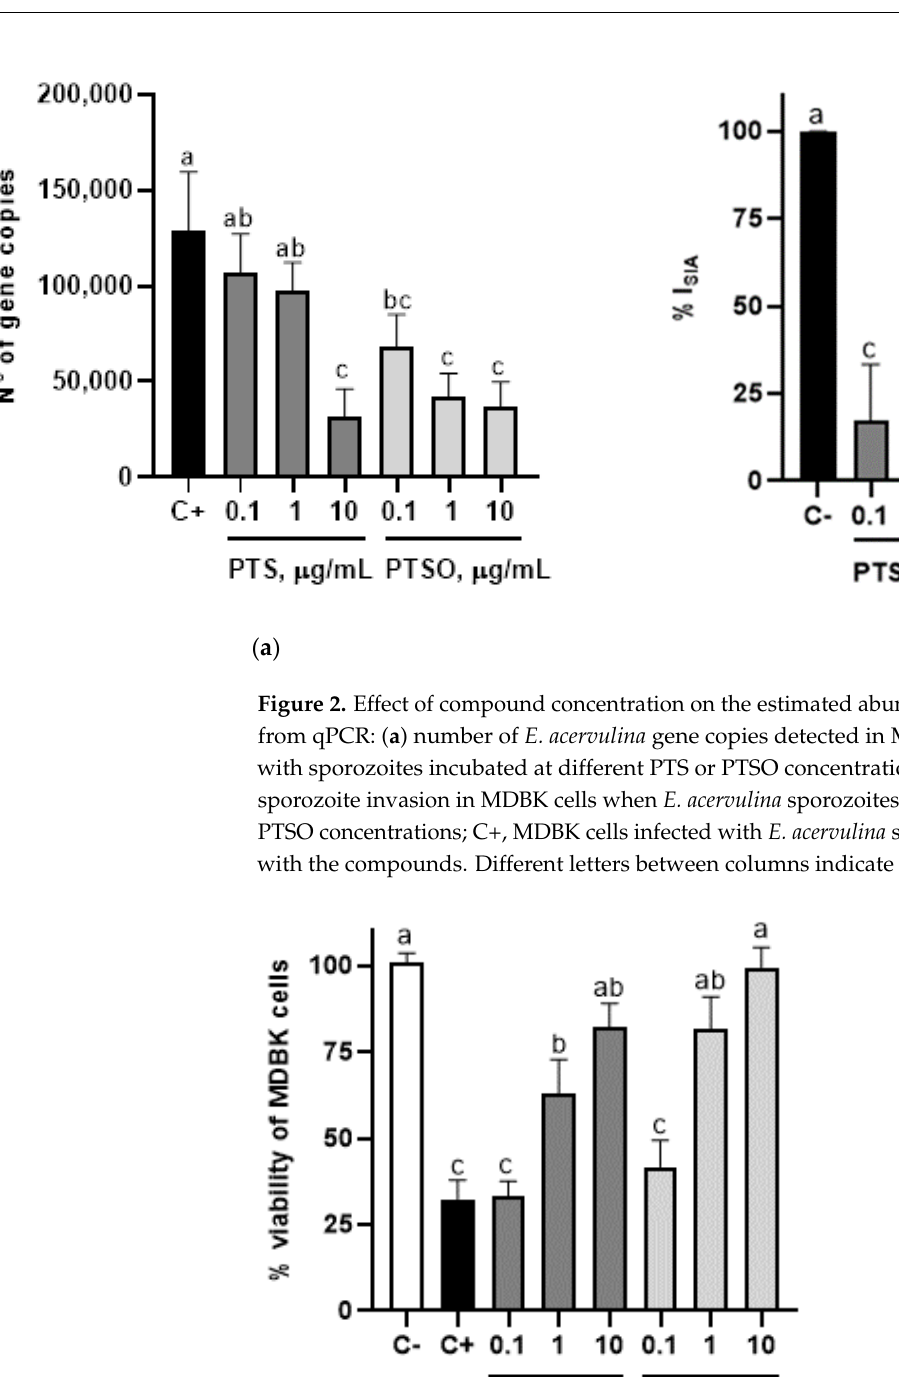
( b ) Figure 4. Effect of pre-incubation with PTS and PTSO on MDBK cells, estimated by qPCR: ( a ) num- ber of E. acervulina gene copies detected in MDBK cells incubated at different PTS or PTSO concen- trations 24 h before the infection with sporozoites; ( b ) percentage of inhibition of sporozoite inva- sion in MDBK cells incubated at different concentrations of PTS or PTSO before the infection with E. acervulina sporozoites. Different letters between columns indicate significant differences at p < 0.05. 3.4. Preventive Effect The incubation of MDBK cells with PTS and PTSO reduced the number of gene copies of sporozoites significantly, showing the best results at the concentration 1 µg/mL of PTS (9.2 × 10 4 ± 9.28 × 10 3 ) and 0.1, 1 and 10 µg/mL of PTSO (7.8 × 10 4 ± 9.03x 10 3 ; 6.3 × 10 4 ± 7.10 × 10 3 and 4.7 × 10 4 ± 1.03 × 10 4 ) compared to positive control (1.5 × 10 5 ± 1.4 × 10 4 ). Never- theless, only PTSO at a concentration of 10 µg/mL was able to increase the percentage of